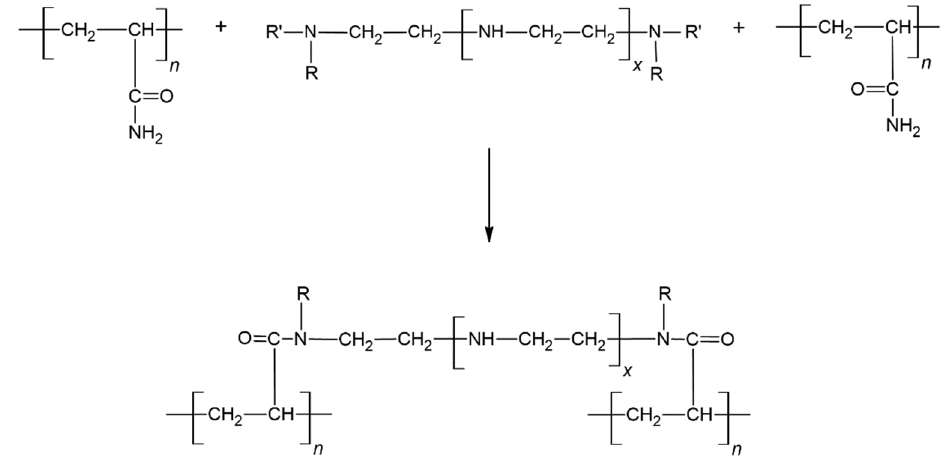
Figure 2. Crosslinking reaction through a transamidation reaction